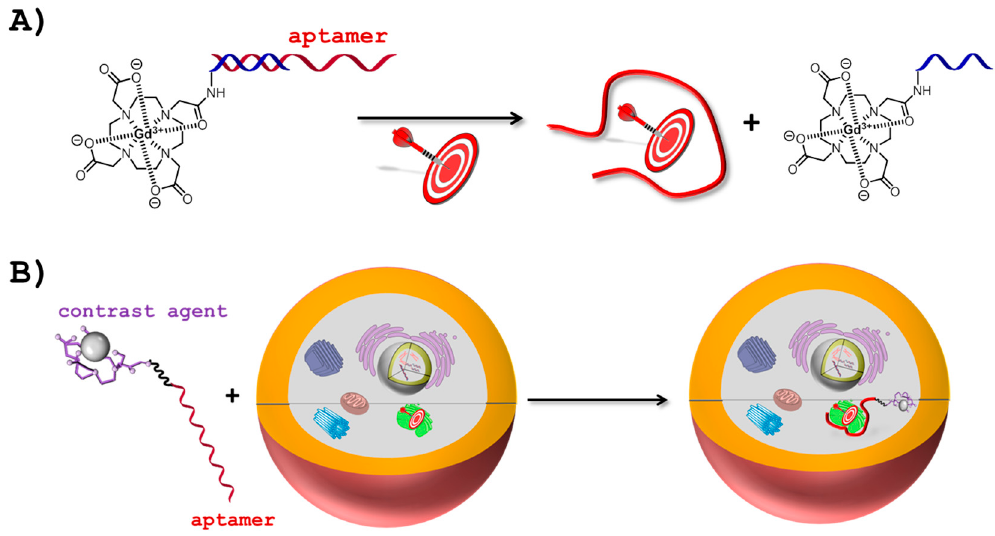
Figure 1. Strategies for the construction of aptamers acting as smart contrast agents: ( A ) Response to a biochemical stimuli: An oligonucleotide is equipped with a Gd 3+ -DOTA complex. This oligonucleotide is complementary to part of the aptamer and upon binding to the target, the structural reorganization causes the Gd 3+ -DOTA-labeled strand to dissociate from the duplex, which in turn increases the relaxation time and thus the brightness of the MRI signal [46]; ( B ) Vectoring to intended target: An aptamer is equipped with a contrast agent and will vector the probe directly to the intended target.